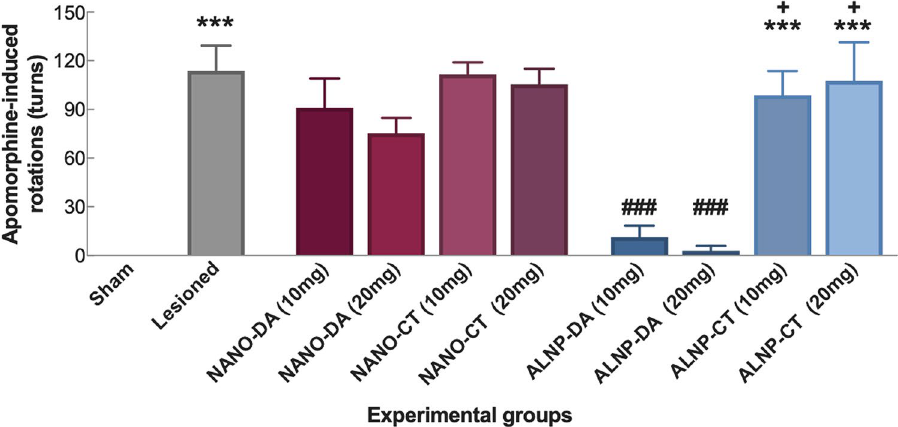
Figure 8. Apomorphine-induced contralateral rotations in Sham and 6-OHDA-Lesioned animals treated with NANO-Control (NANO-CT; 10 or 20 mg/animal; NANO + Dopamine (NANO + DA; 10 or 20 mg/animal); dopamine-loaded albumin/PLGA nanosystems (ALNP-DA; 10 or 20 mg/animal); and unloaded control albumin/PLGA nanosystems (ALNP-CT; 10 and 20 mg/animal). Data are expressed as number of contralateral turns, submitted to one-way ANOVA analysis, followed by the Tukey post-test. (***) p < 0.001 when compared to Sham group; ( ### ) p < 0.001 with respect to Lesioned group; ( + ) p < 0.01 compared to ALNP-DA 20 mg. N = 7